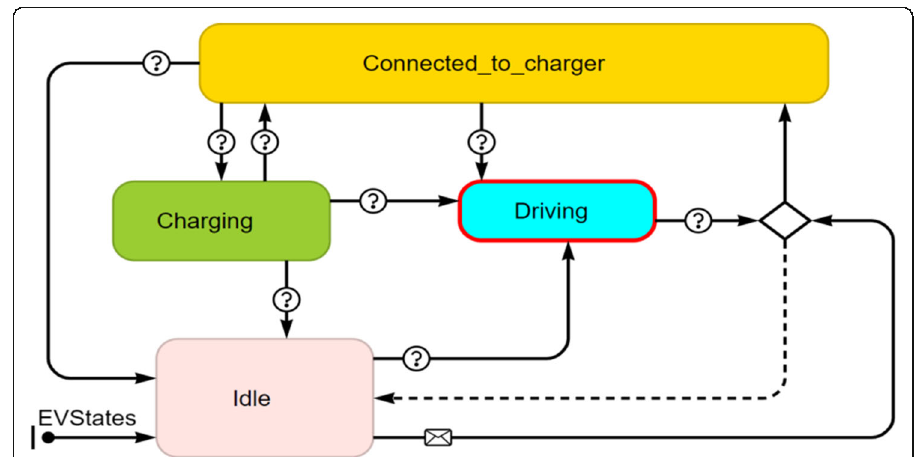
Fig. 13 Flowchart with states attainable by the ElectricVehicle agent and transitions between those, as depicted by AnyLogic during simulation